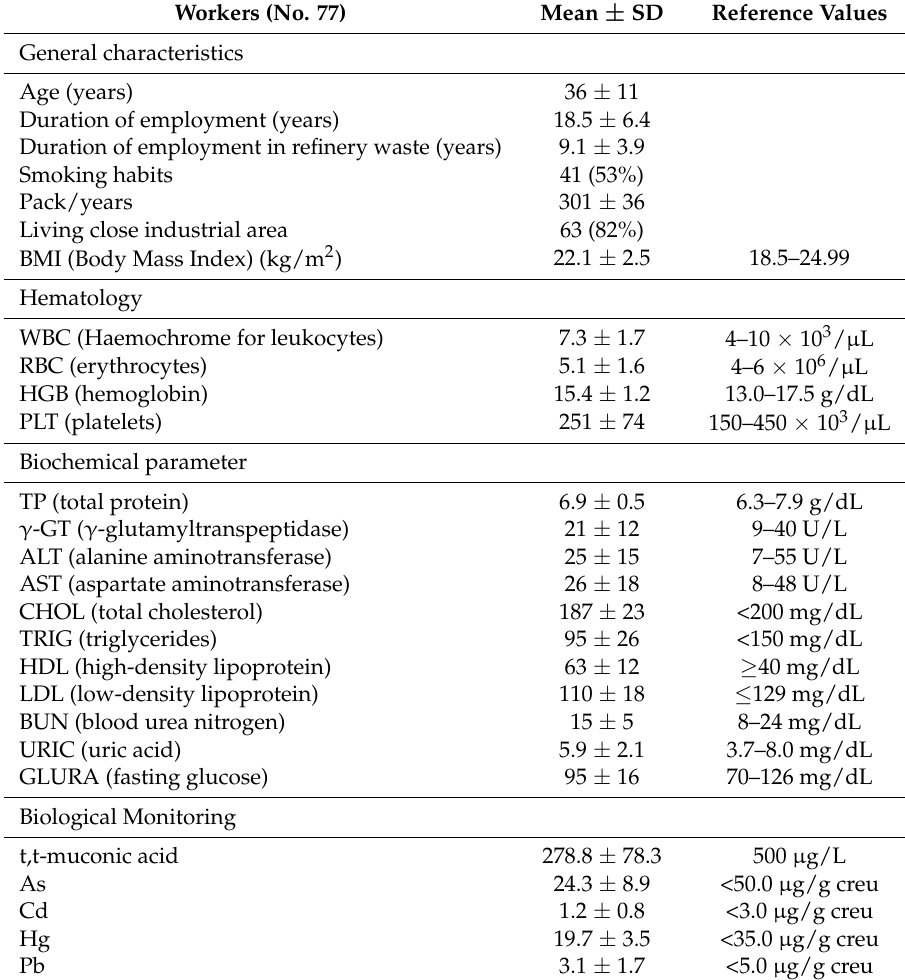
Table 3. The individual characteristics and laboratory results in observed workers.